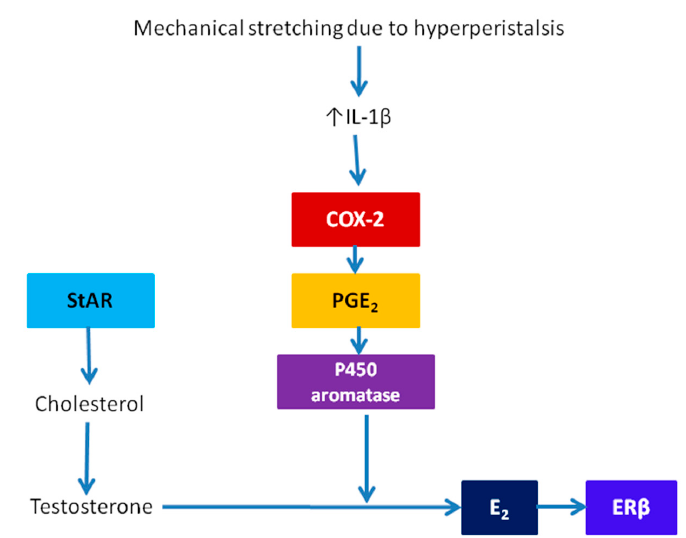
Figure 1. The key molecular signaling events initiated by the tissue injury and repair (TIAR) that leads to the increased local production of estradiol, as proposed by Leyendecker et al. [29,30]. Gene/protein names: COX-2: cyclooxygenase-2; E 2 : 17 β -estradial; ER β : estrogen receptor β ; IL-1 β : interleukin-1 β ; P450 aromatase: aromatase; PGE 2 : prostaglandin E2; StAR: steroidogenic acute regulatory protein.